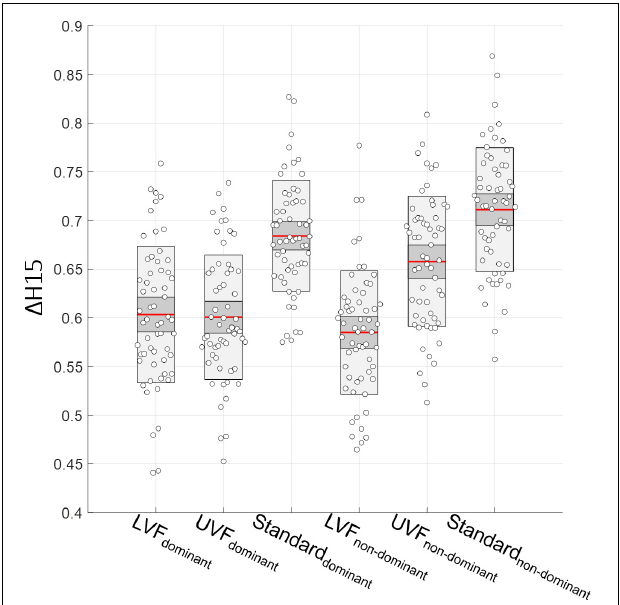
FIGURE 6 | Degree of multifractality (cid:49) H15 in the three conditions (LVF, UVF, and Standard) for the dominant and non-dominant hands (from left to right).